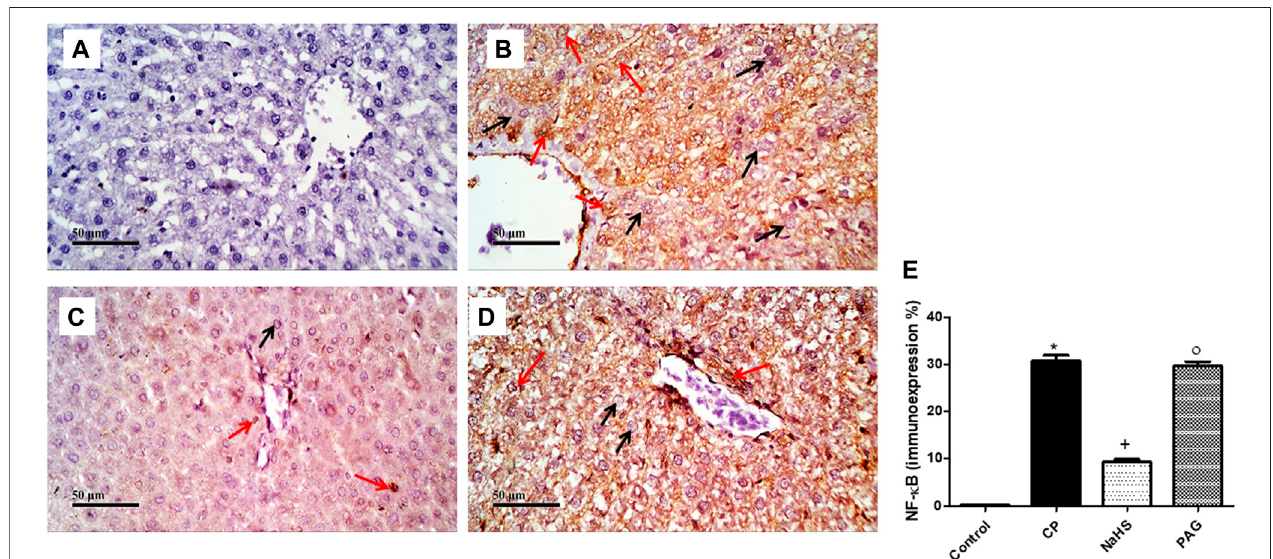
FIGURE 6 | Representative photomicrographs of immunohistochemical analysis of hepatic NF- κ B protein expression (A) Control group, (B) CP group, (C) NaHS group, (D) and PAG group. All reactive hepatocytes are labeled with red arrows, while black arrows indicate negative reactive hepatocytes. (E) A semi-quantitative analysisofNF- κ B inrat ’ sliver tissue. Dataare representedas mean ±SEM. *, +, ° aresigni fi cantlydifferentfrom control, CPand NaHS groups, respectively,where n =6 and p < 0.05. CP; cyclophosphamide, PAG; DL-propargylglycine, NF- κ B; nuclear factor kappa B.